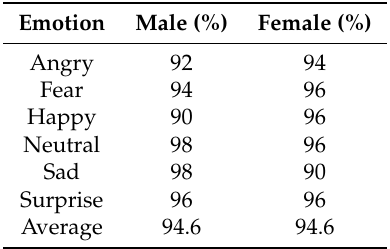
Table 3. Accuracy of male and female group using